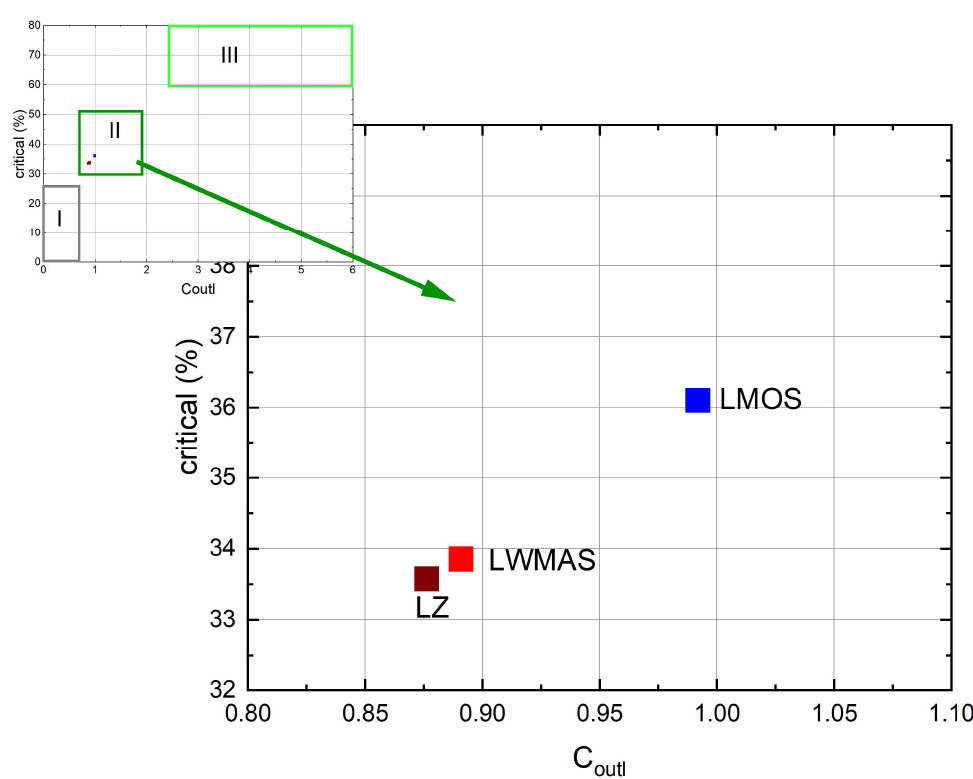
Figure 8. The relationship between the percentage share of critical elements in studied fly ashes and the C outl prospective coefficient compared to the classification of coal ashes enriched in REE [26]. Source of REY: I—not prospective; II—prospective; III—highly prospective.